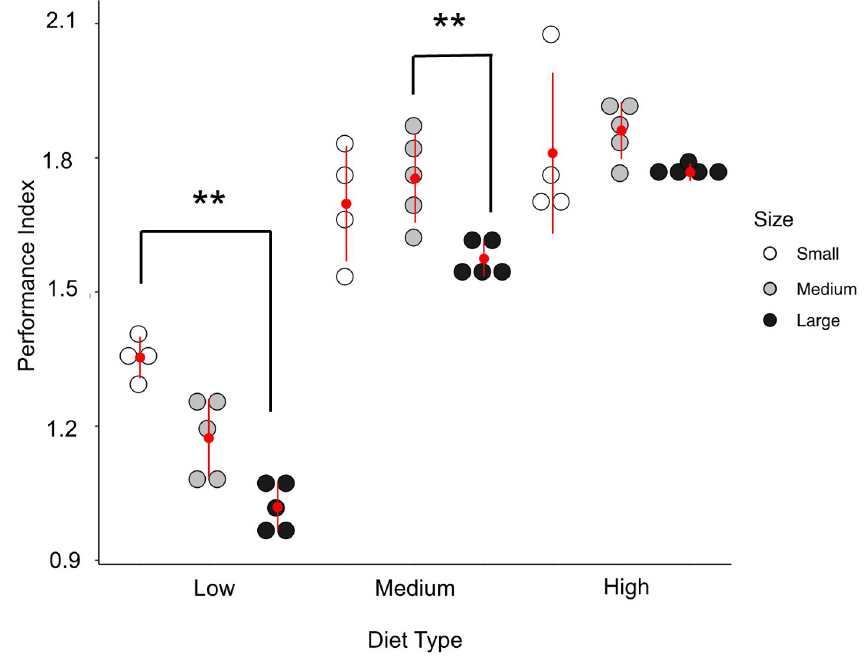
Fig 3. Productivity for each container size and diet type. The individual points represent the productivity for each replicate with the red dot representing the mean productivity for that treatment (n = 5 trays/treatment). The red line either side of the mean represents ± 1